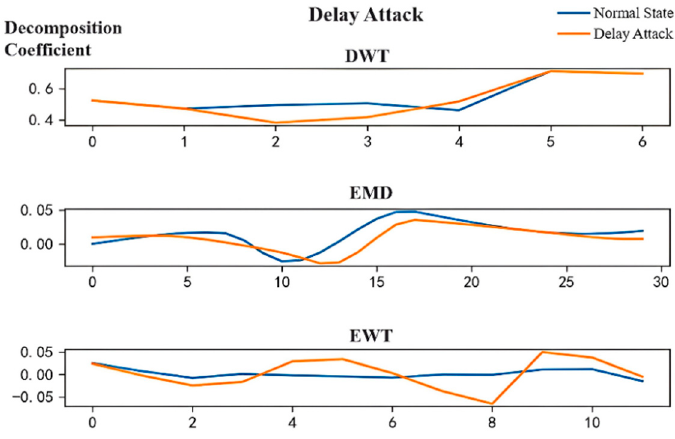
Figure 7. Decomposition coefficients of time-frequency transform under a delay attack.